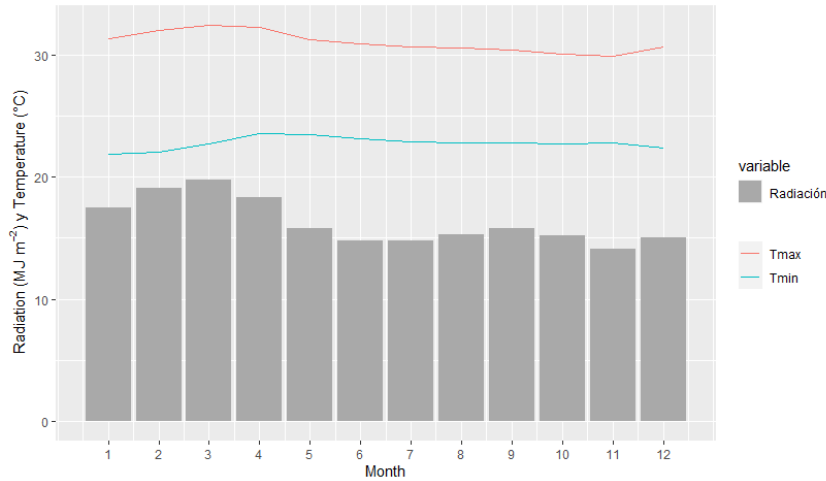
Figure 8. Monthly temperature and radiation regime in the selected APBs in the period from 1995 to 2015.